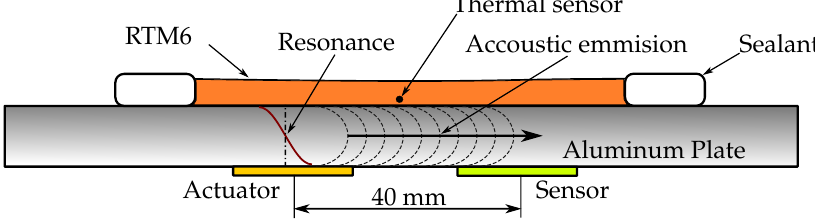
Figure 2. Test setup and principle for ultrasonic spectroscopy cure monitoring of the epoxy RTM 6with a piezoelectric actuator and a piezoelectric